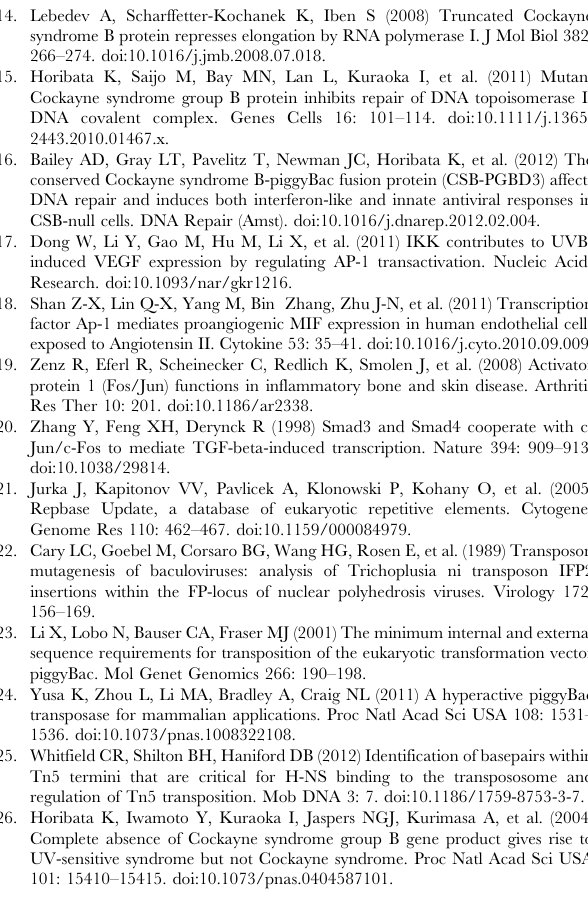
Table S6 105 CSB-PGBD3 peaks overlap at least 10 of 18 RNAPII peak datasets from 15 cell lines available in the UCSC